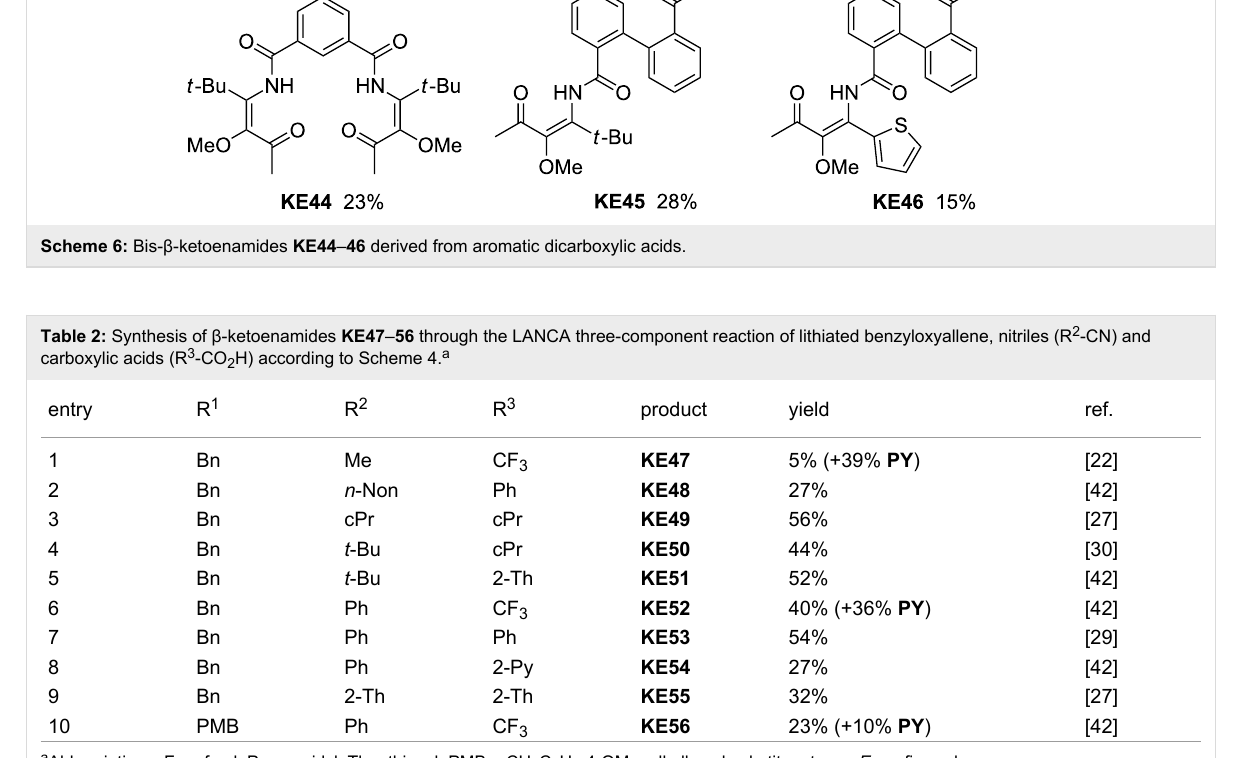
a Abbreviations: Fu = furyl, Py = pyridyl, Th = thienyl, PMB = CH 2 C 6 H 4 -4-OMe; all alkenyl substituents are E -configured.